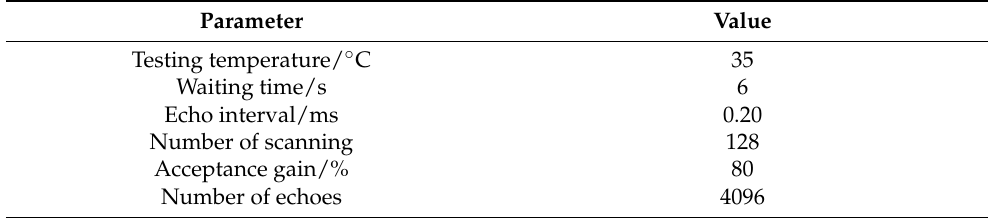
Table 1. Experimental conditions for NMR